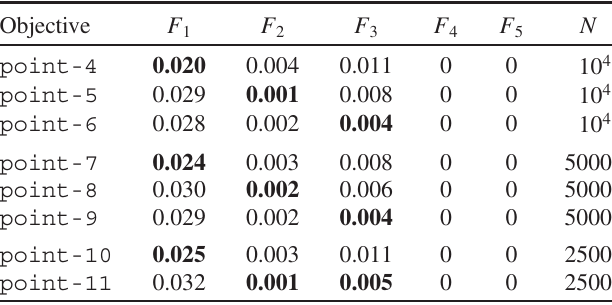
TABLE VI. The points with the smallest value of F 1 ( point-4, 7,10 ), F point-5,8,11 ) and F point-6,9,11 ), out of 2 ( 3 ( all the points (first row in Table V) that satisfy the constraints in Eq. (28) and have all objectives better than the manually obtained solution (first row in Table III). All the digits of the objective function values computed with 500 turns in TRACY are used for the comparison, and the bold numbers denote the minimal value of the respective objective before rounding. The last column denotes the size of the initial sample. The case with N ¼ 10 4 is described in Sec. V B. The cases with N ¼ 5000 and N ¼ 2500 are described